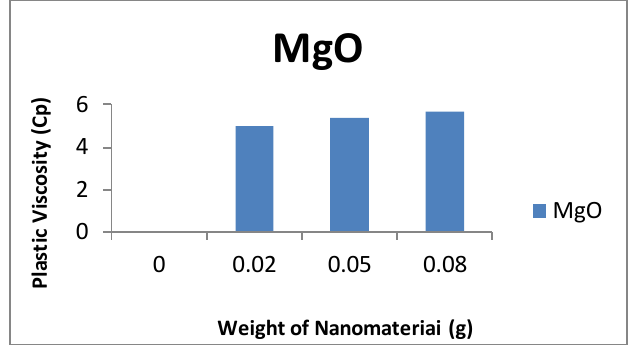
Figure 6: Effect of Nano-magnesium oxide Weight on Plastic Viscosity of attapulgite water-based Mud.